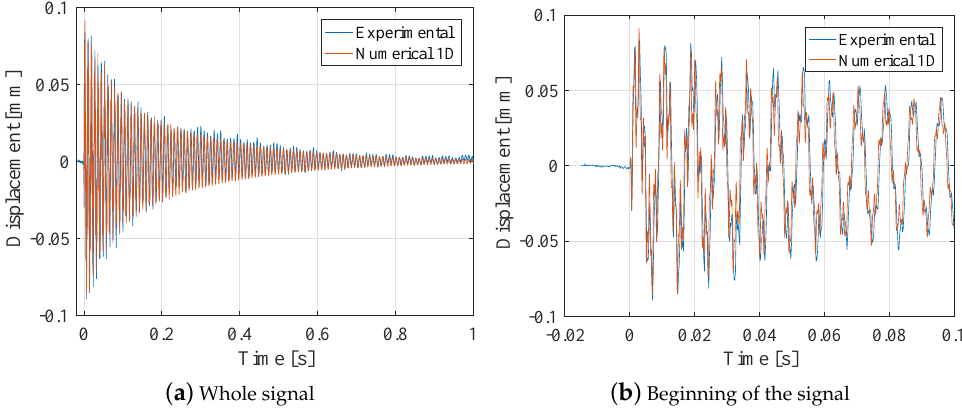
Figure 14. Comparison of numerical and experimental transverse displacement for the neutral axis point of the clamped–clamped beam at abscissa x = 25.25